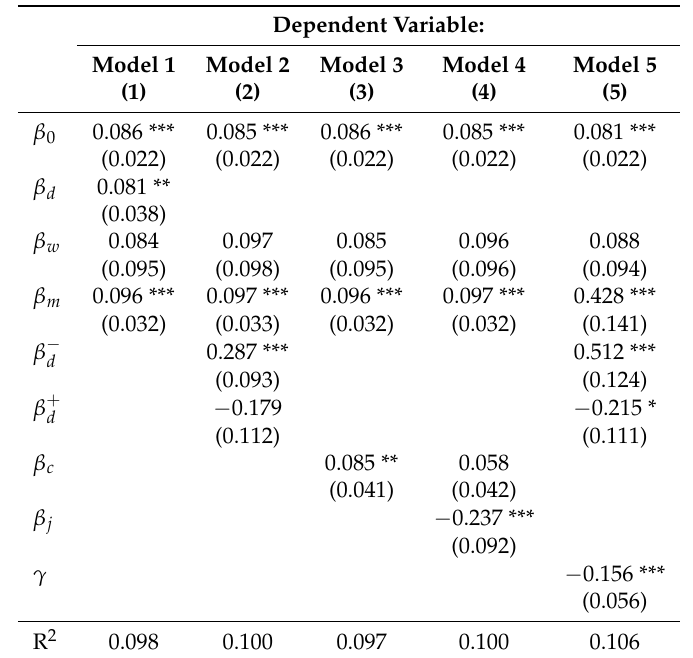
Table 3. HAR-RV estimation results - 7-day